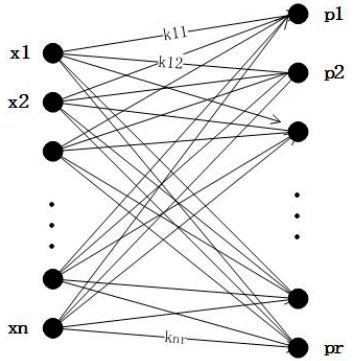
Figure 3. The process of data mapping.